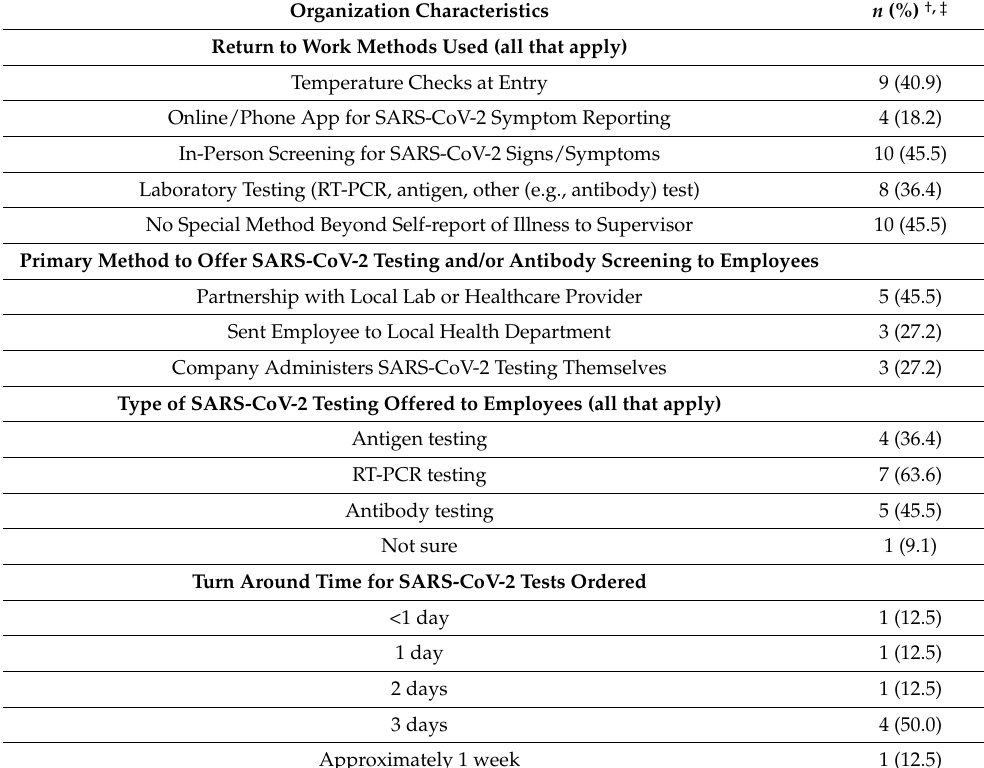
Table 2. SARS-CoV-2 testing practices and return-to-work strategies among participating companies who offered testing ( n = 11) in the Employer Testing of SARS-CoV-2 History (ETCH) Phase 1 Study, January–April